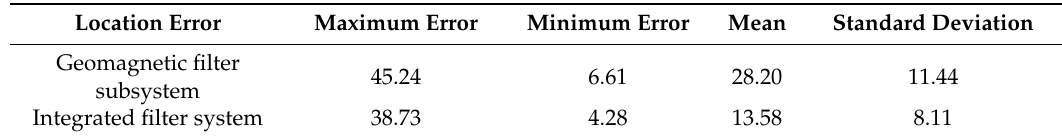
Table 3. Results of flight experiment (Unit: